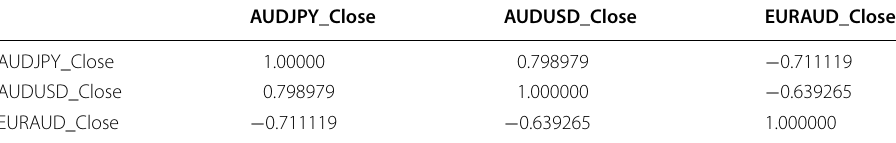
Table 2 Pearson’s correlation coefficient between AUDJPY, AUDUSD, EURAUD AUDJPY_Close AUDUSD_Close